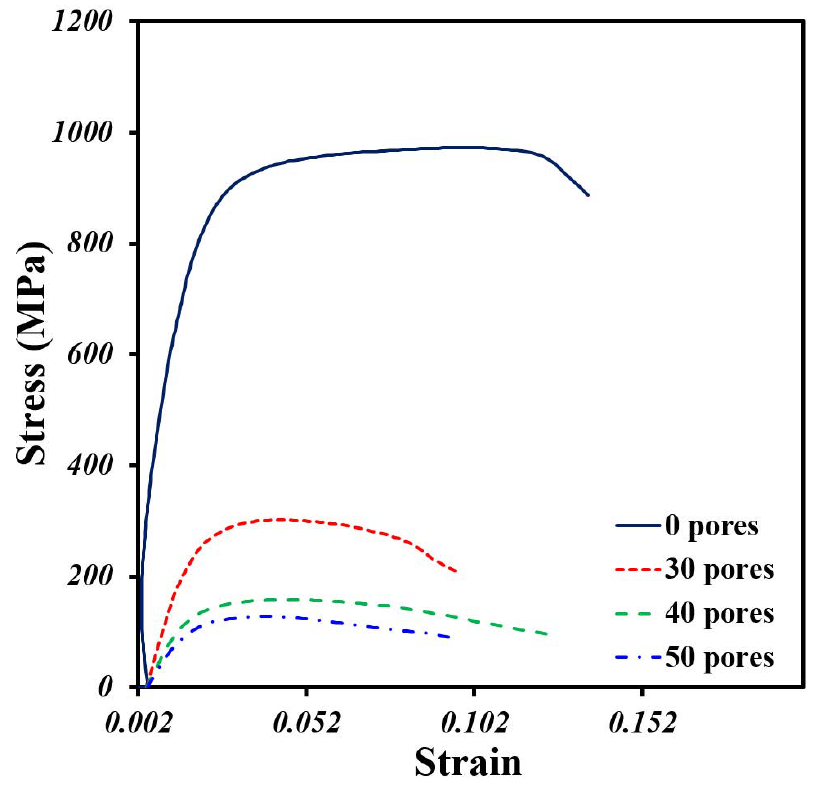
Figure 8. Stress–strain compression curves of Ti64/20Ag samples with different volume fractions of pore formers.